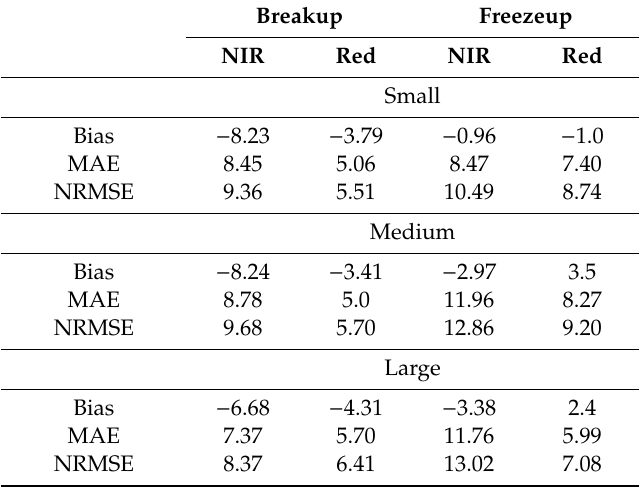
Table 1. Statistical validation results for the remotely sensed lake ice breakup and freezeup dates.